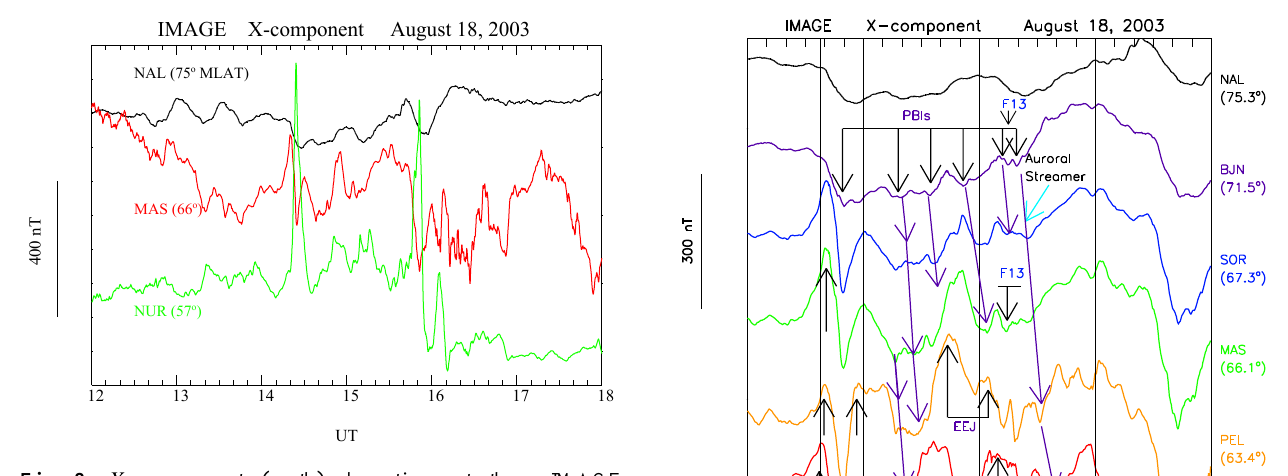
Fig. 8. X component (north) deflections at three IMAGE stations during the interval 12:00–18:00UT. The stations are NAL (75.2 ◦ MLAT; black), MAS (66.2 ◦ MLAT; red), and NUR (56.9 ◦ MLAT (green).